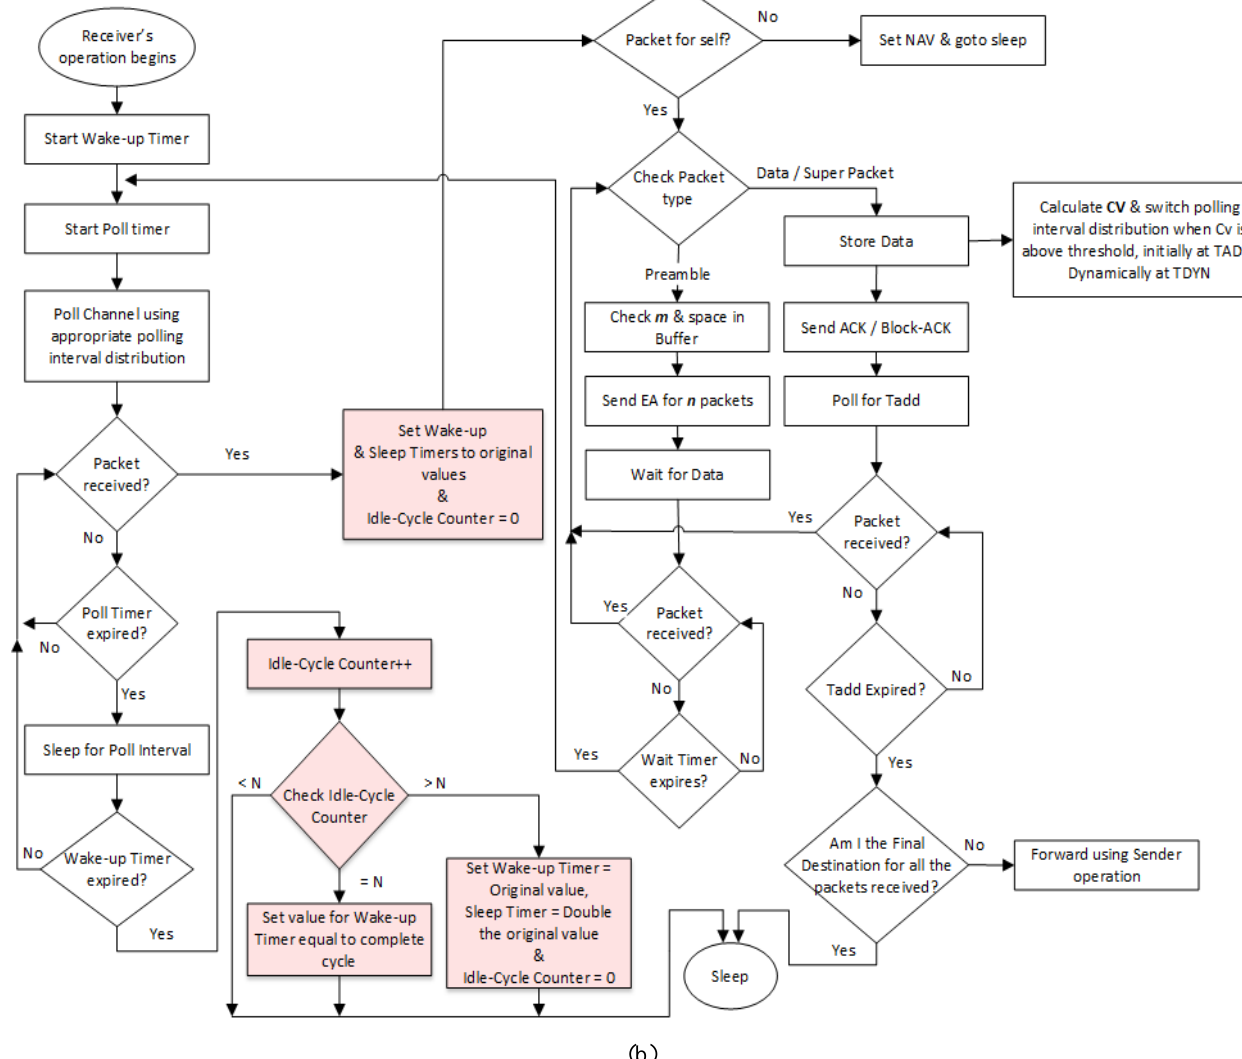
Fig. 4 . Operation of ADP-MAC: (a) Sender (b) Receiver